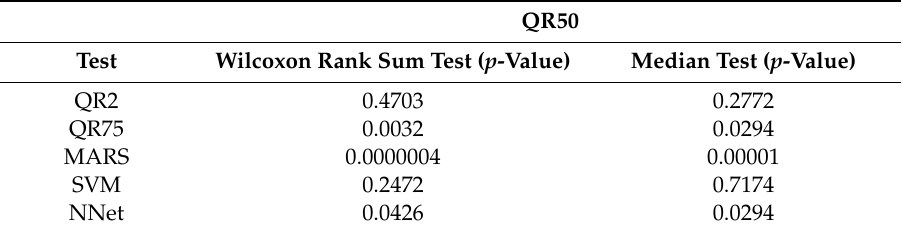
Table 11. The statistical tests to show the di ff erences between models for the absolute percentage errors of ROI for each